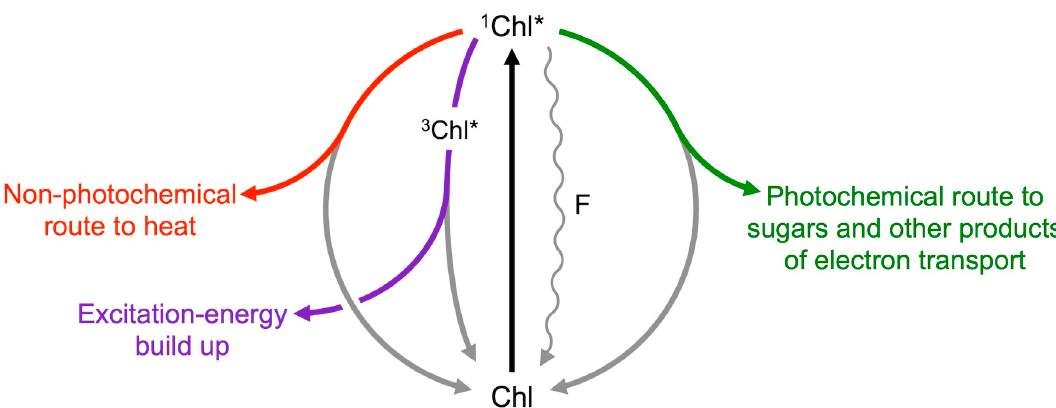
Figure 6. Possible fates of excitation energy once a photon of light is absorbed by a molecule of chlorophyll resulting in conversion from the ground state (Chl) to the singlet excited state ( 1 Chl*). When light is not saturating for photosynthesis, the majority of chlorophyll molecules pass their excitation energy to neighboring chlorophyll molecules via resonance transfer (resulting in return of the first chlorophyll molecule to its ground state). This process can be repeated until the energy reaches a reaction center chlorophyll molecule that undergoes charge separation, resulting in an electron entering the photosynthetic electron transport chain (photochemical route denoted in green, returning the reaction center chlorophyll molecule to its ground state). As light levels become increasingly excessive, excess excitation energy is increasingly dissipated preemptively as thermal energy via a regulated pathway (non-photochemical route denoted in red that also returns the excited chlorophyll molecule to its ground state; see text for regulation of the xanthophyll cycle and engagement of zeaxanthin in energy dissipation). When the combined levels of photochemical and regulated non-photochemical routes are insufficient to swiftly de-excite all excited singlet chlorophyll, conversion to triplet excited chlorophyll ( 3 Chl*) takes place, which represents a temporary build-up of excess excitation energy (purple route). In the presence of molecular oxygen, triplet excited chlorophyll returns to its ground state by transfer of excitation energy to oxygen, resulting in the formation of singlet excited oxygen (not shown). A small percentage of the chlorophyll molecules return to ground state directly from the singlet excited state (wavy line), emitting fluorescence (F). Although only representing a very small fraction of the excitation energy, and thus not a major route for deexcitation, fluorescence emission provides valuable quantitative information about the other fates (particularly the regulated non-photochemical and photochemical routes).